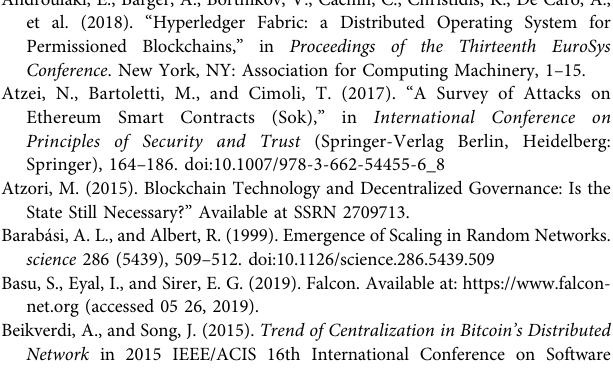
Frontiers in Blockchain |